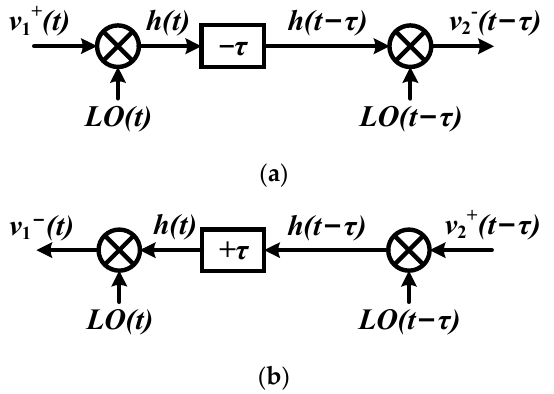
Figure 2. Doubly square-wave mixing system with LTI and reciprocal property: ( a ) original case; ( b ) with time delay τ .